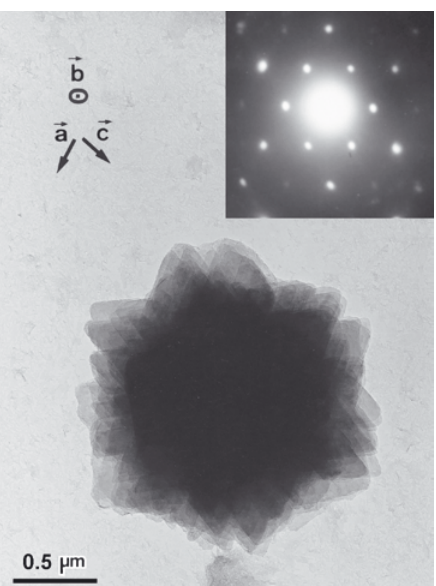
Figure 9. Final stage of the development of the nordstrandite particles into a star-shaped configuration. The selected area electron diffraction (SAED) insert indicates that the various planes of the plates are at right angles to the b-axis.